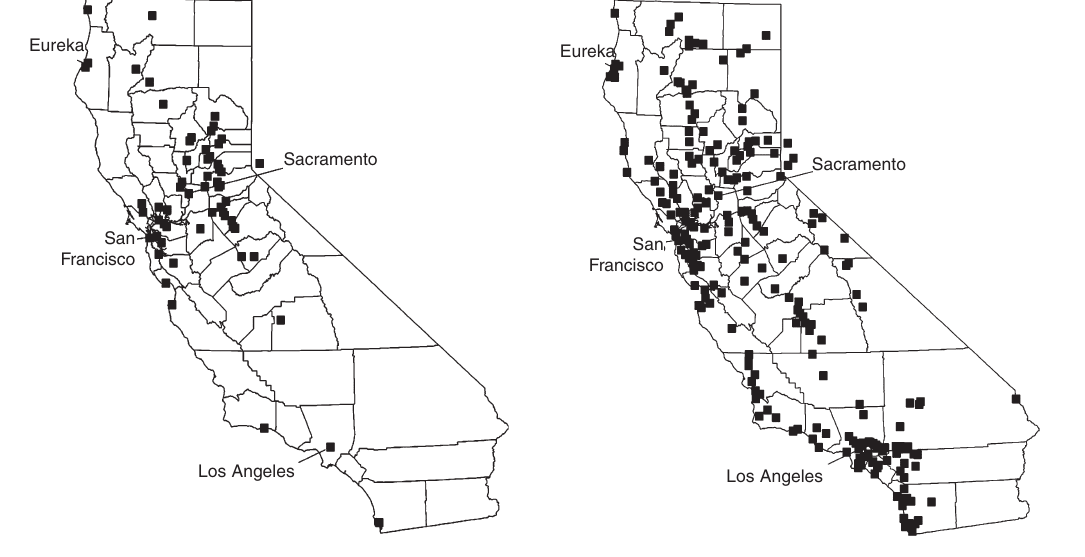
1859 (modified from Toppozada et al. , 1981).